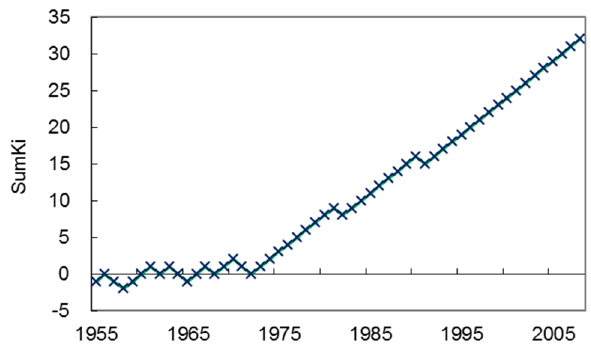
Figure 5. Time series of Sum K i at the Daning hydrometric station for 1955–2008.